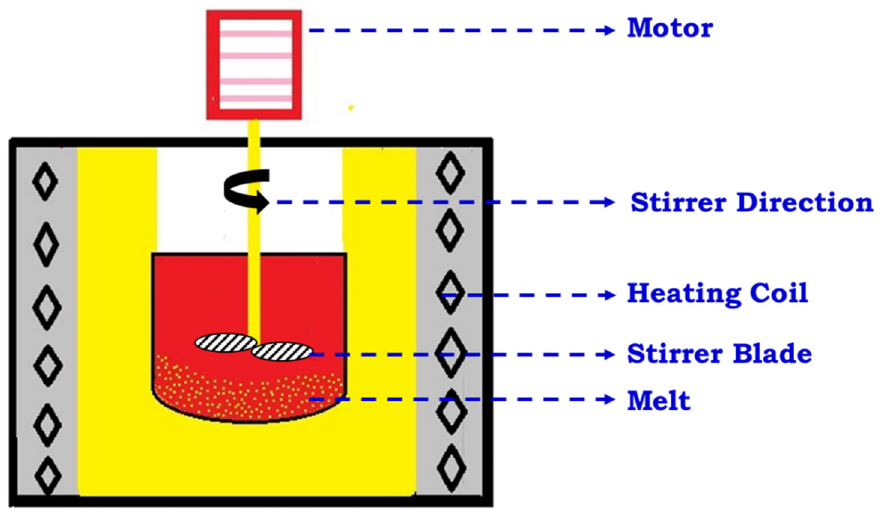
Figure 3. Schematic diagram of stir-casting technique.